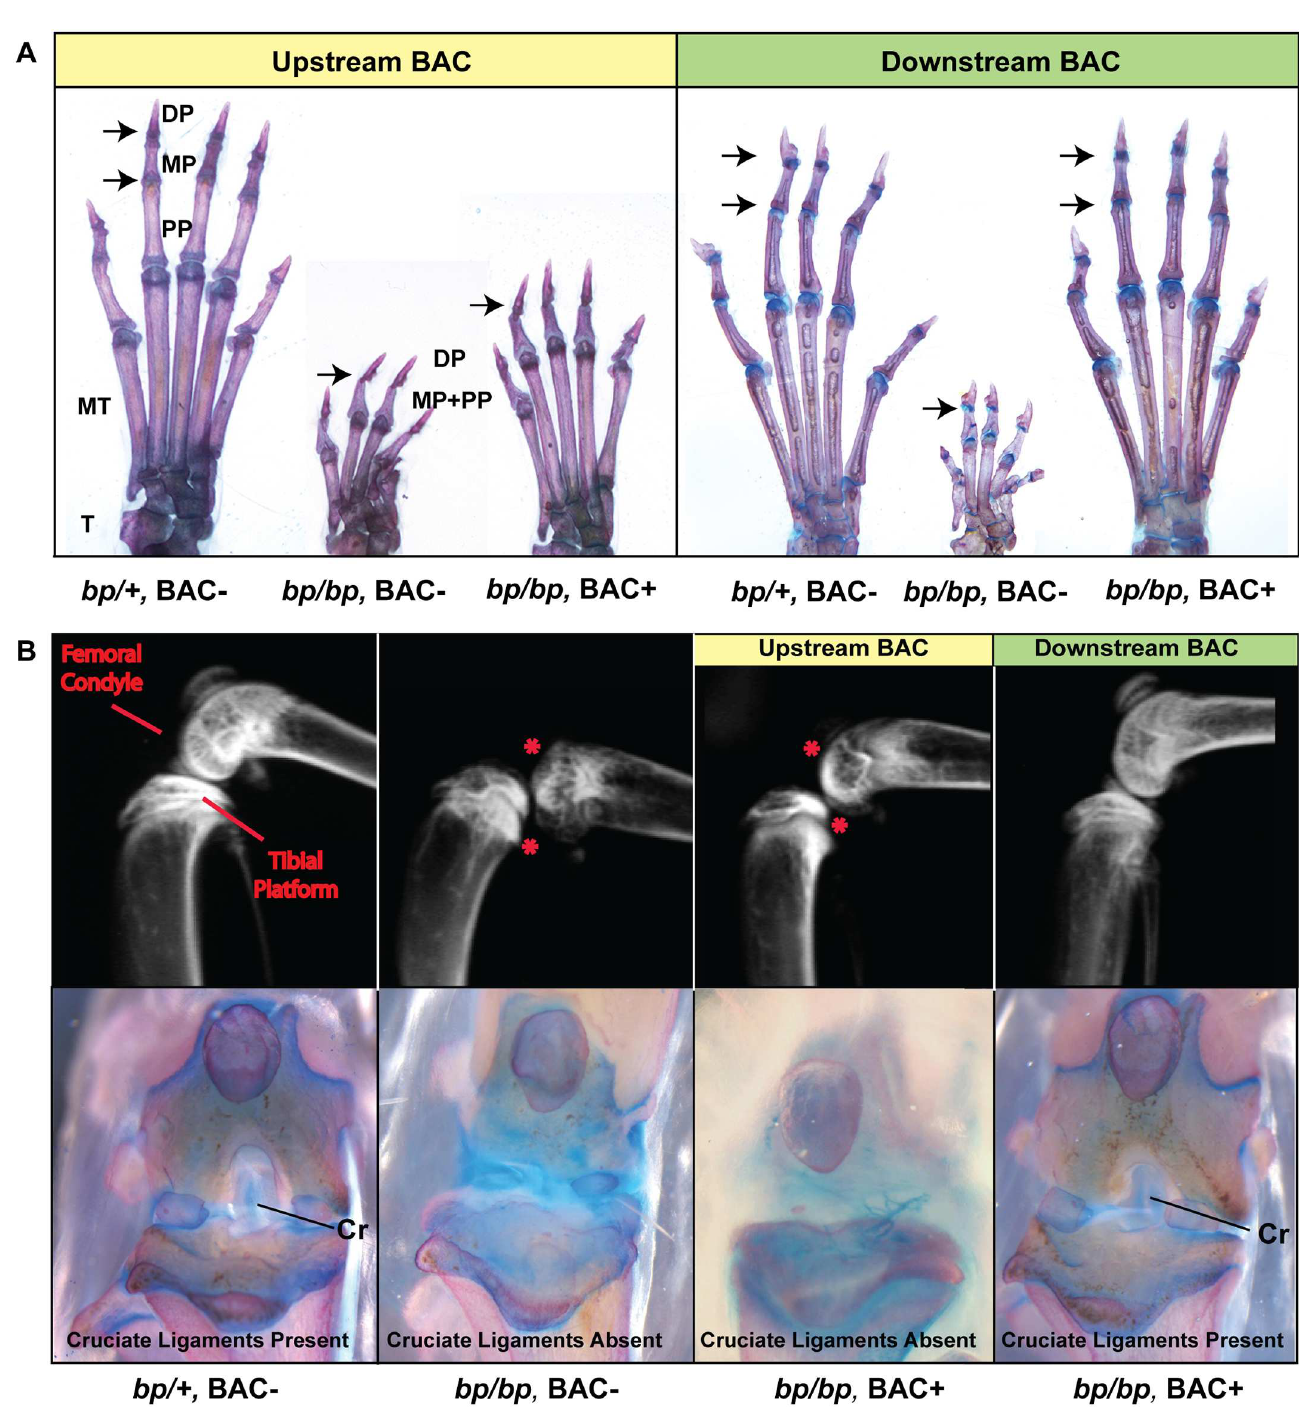
Fig 5. Downstream Gdf5 regulatory regions are required for full rescue of brachypodism joint defects. ( A ) Skeletalpreparations of hindpawsof transgenicrescue experiments with either Upstream (yellow)and Downstream(green)BACs. Controlmice ( bp/+ , BAC- ; left) are shown in comparison to brachypodism homozygous mutants that are either BAC negative( bp/bp , BAC- ; center) or are also carrying either Upstream or DownstreamBAC positive ( bp/bp , BAC+ ; right). In each paneldigit I is to the right. DP (distal phalange), MP (middle phalange), PP (proximal phalange), MT (metatarsal), and T (tarsal). Arrows indicatelocationof the interphalangealjoints. ( B ) (Top) Radiographsof adult mouse knee joints. Asterisks ( * ) indicatethe femoral and tibialdysmorphologies typical of bp/bp mutants. (Bottom) Alcian Blue (cartilage)and Alizarin red (bone) preparations of adult knees from rescue experiments. Cruciate ligaments(Cr) are usuallymissing from bp/bp mice. Note that the presenceof the Downstream BAC ( bp/bp , Downstream BAC+ animals)fully restores interphalangealjoints, adult knee joint articularmorphology, and cruciate ligaments; whilethe Upstream BAC does